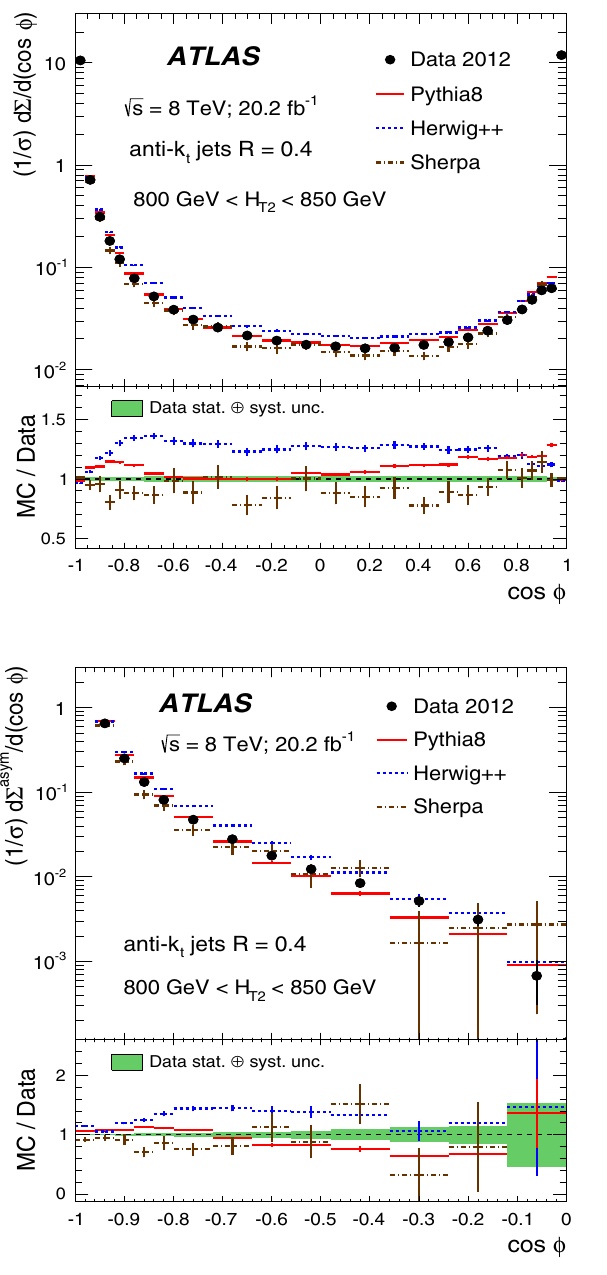
Fig. 1 Detector-level distributions for the TEEC (top) and ATEEC functions (bottom) for the first and the last H T2 intervals chosen in this analysis, together with MC predictions from Pythia8 , Herwig++ and Sherpa . The total uncertainty, including statistical and detector